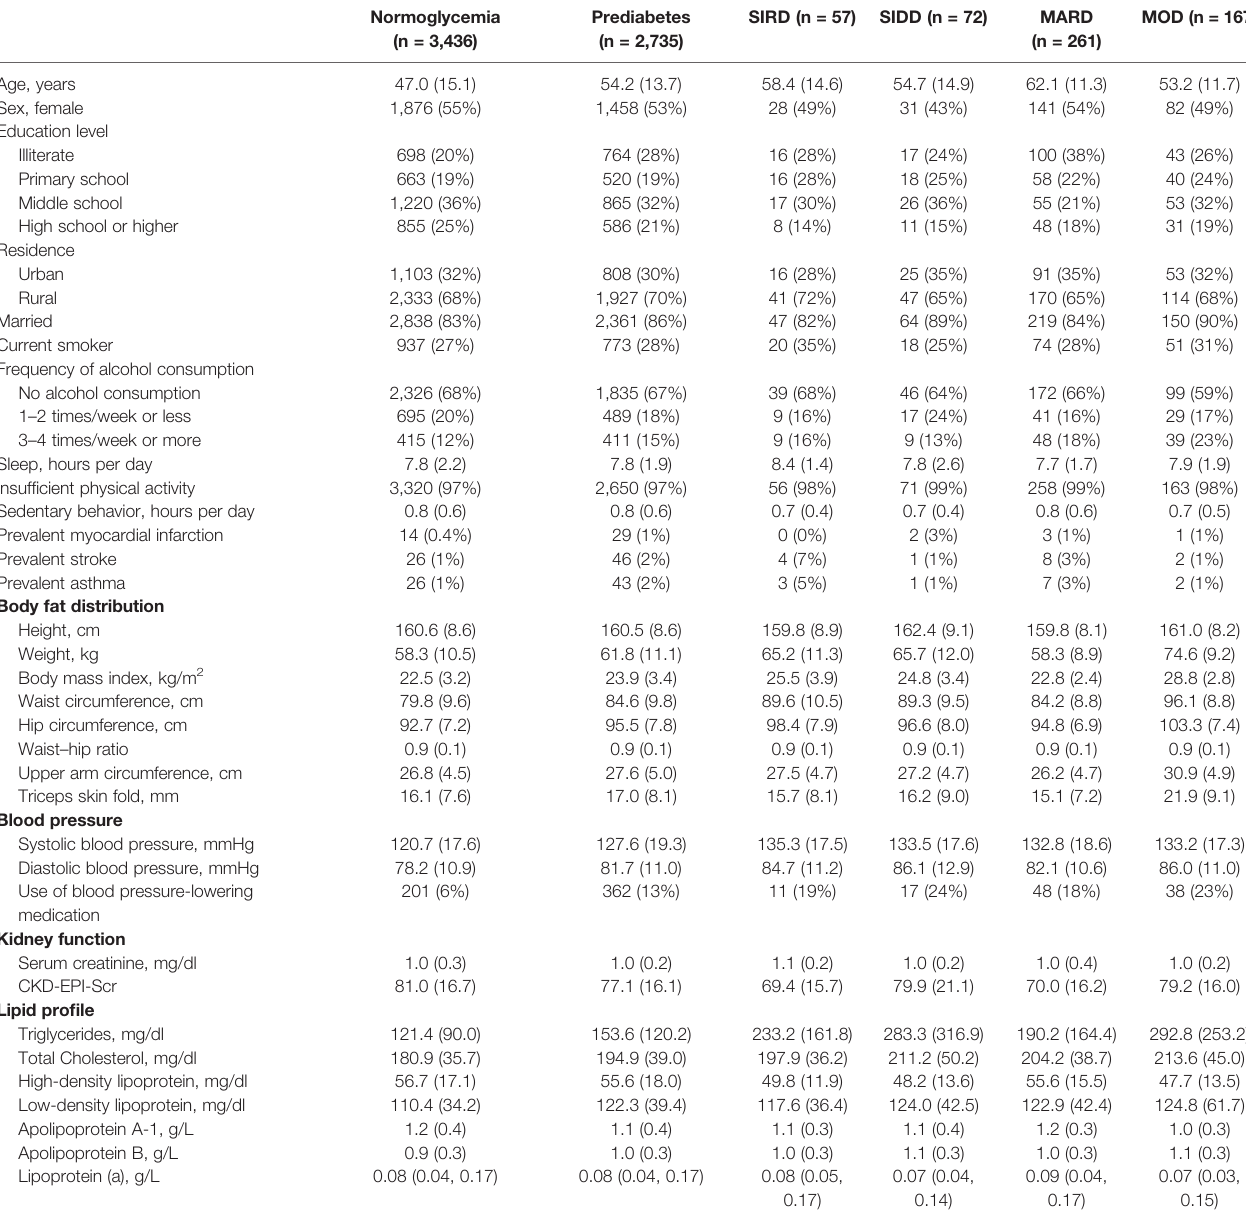
TABLE 1 | Characteristics of the study participants at the time of diagnosis among different glycemic